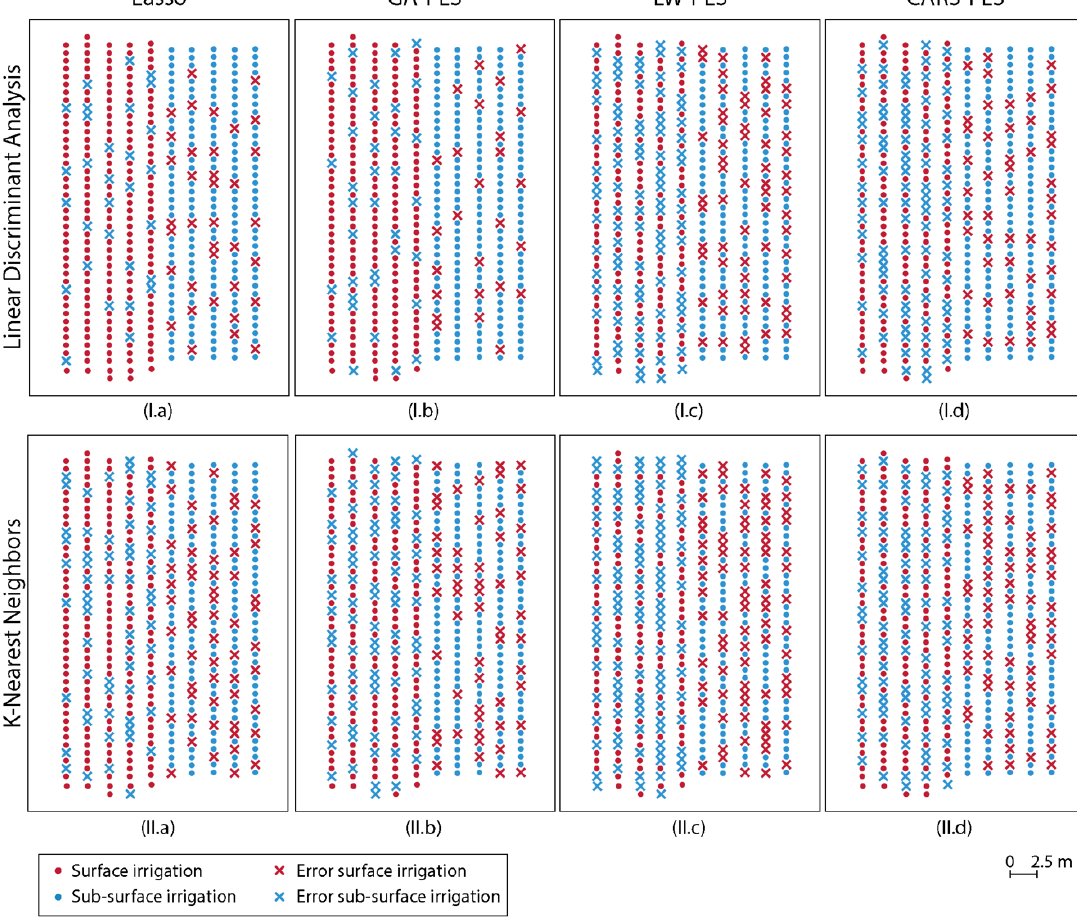
Figure 7. Classification results per classifier ((I) Linear Discriminant Analysis; and (II) K-Nearest Neighbors) and PLS method: ( a ) Lasso; ( b ) Genetic Algorithm; ( c ) Loading Weights; and ( d ) Competitive Adaptative Reweighted Sampling.